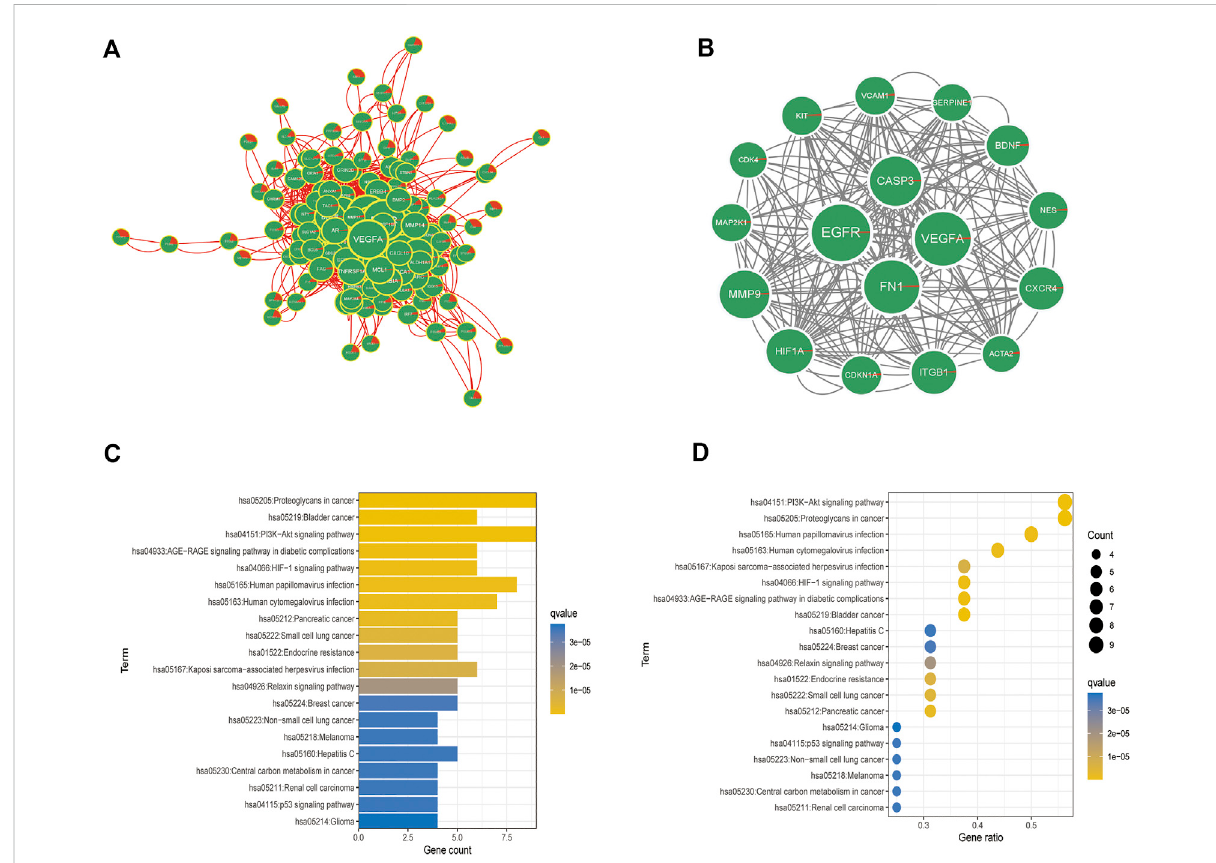
FIGURE 6 Analysis of crucial cluster genes. (A,B) Screening for essential subcluster genes. (C,D) Kyoto Encyclopedia of Genes and Genomes (KEGG) enrichment analysis of essential subcluster genes (top